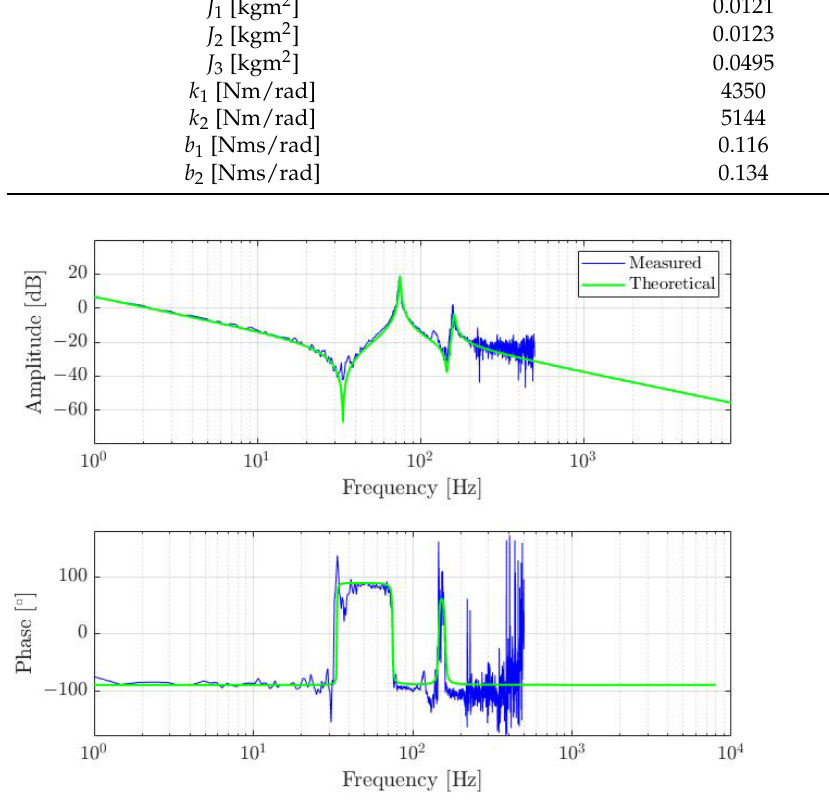
Figure 4. System identification Bode measurement and simulation with random torque input at motor M1 and measured speed output at M1. Measurement with a sample time of 1 ms; resonance modes of the system at 74 and 161